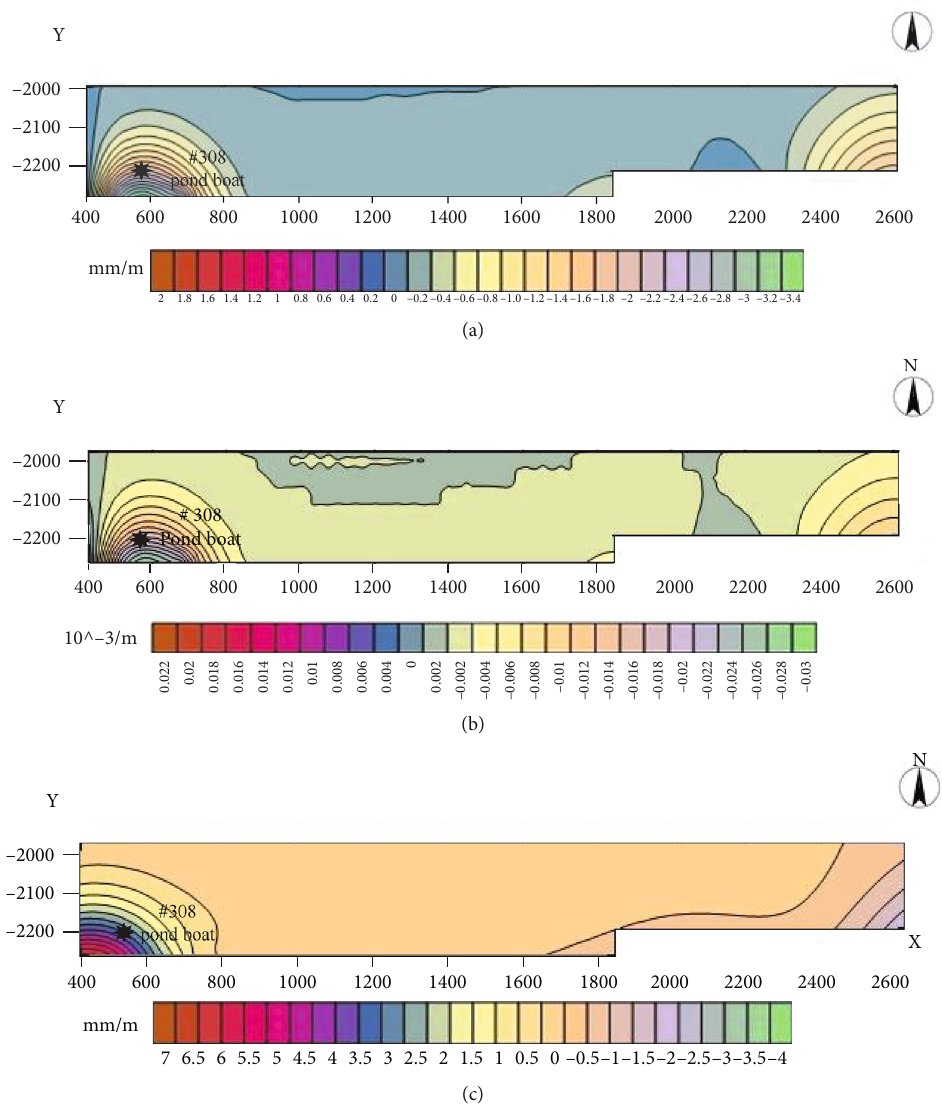
Figure 4: Contour maps of horizontal distortion, inclination, and curvature: (a) horizontal distortion; (b) curvature; (c)